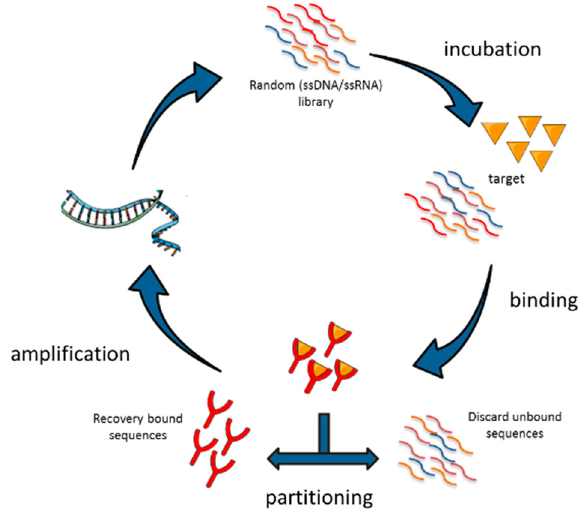
Figure 2. Schematic representation of the systematic evolution of ligands by exponential enrichment (SELEX) procedure. A random single-stranded oligonucleotide library is incubated with the target and then bound sequences are separated from unbound. Bound aptamers are recovered and subjected to amplification. Steps are repeated cyclically to isolate high affinity and specificity aptamers.